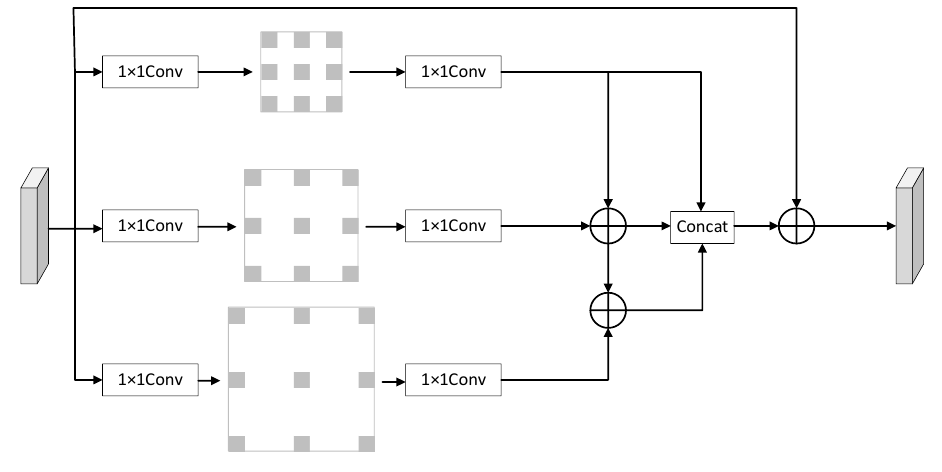
Figure 8. Improved MDCM.